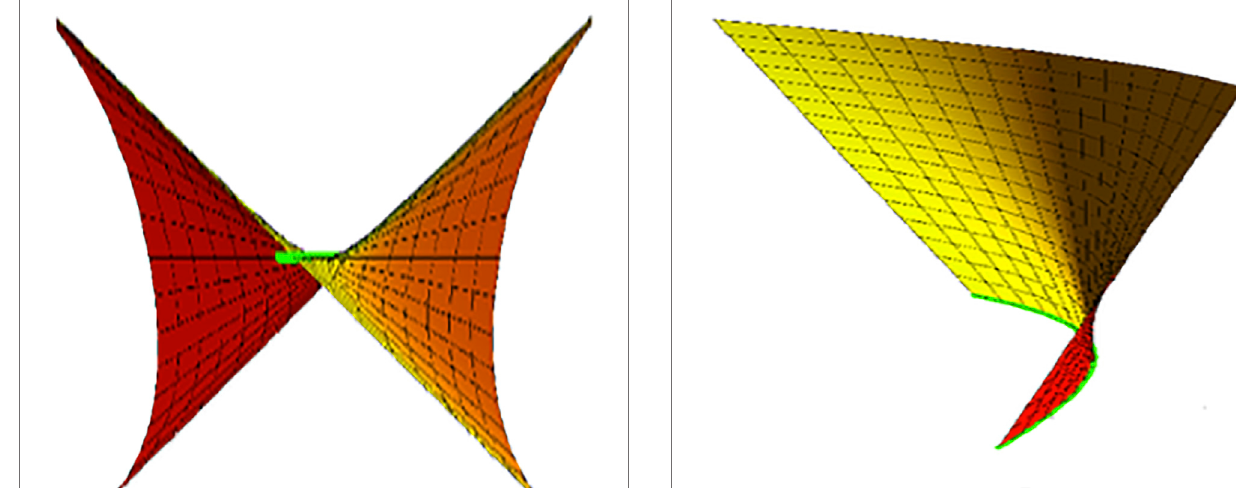
FIGURE 6 | Timelike developable with c (cid:3)